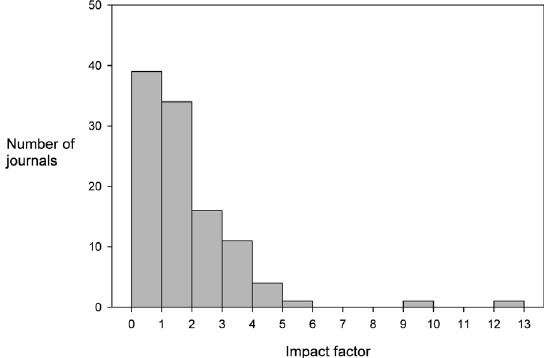
Figure 1. Frequency distribution of journal impact factors from 2004 for 107 journals listed in the ‘Ecology’ category by ISI Web of Science